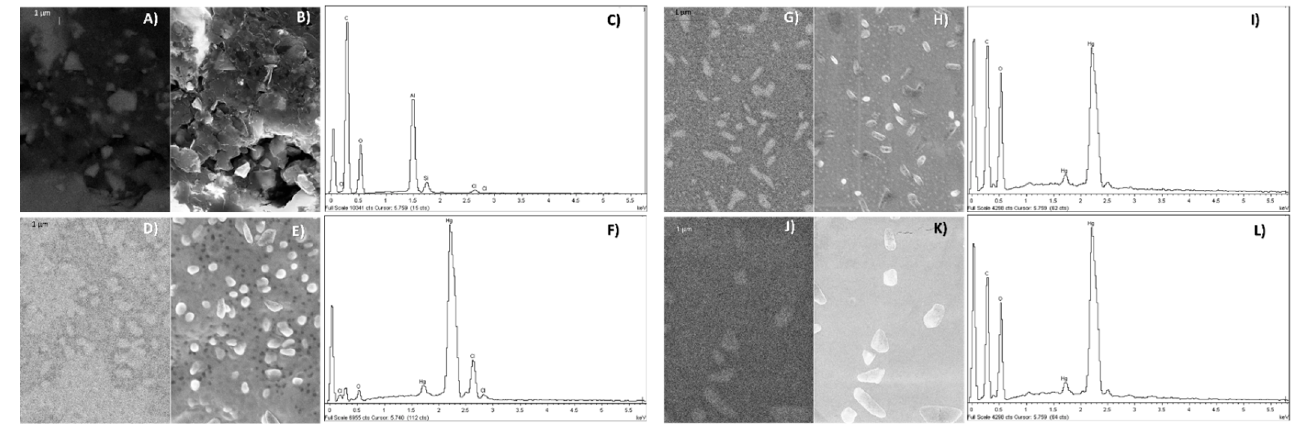
Figure 2. Retrodispersive ( A ), secondary electron SEM image ( B ) and EDX graphs ( C ) for 20% graph- ite. Retrodispersive ( D ), secondary electron SEM image ( E ) and EDX graphs ( F ) for Hg-NPs Route A @graphite electrode. Retrodispersive ( G ), secondary electron SEM image ( H ) and EDX graphs ( I ) for Hg-NPs Route B @graphite electrode. Retrodispersive ( J ), secondary electron SEM image ( K ) and